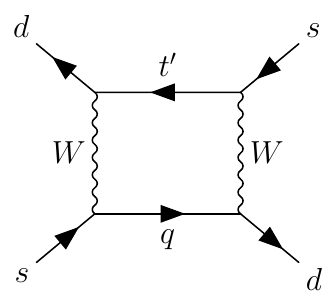
Figure 13 . New contribution to ¯ K 0 → K 0 mixing, q = u, c, t, t 0